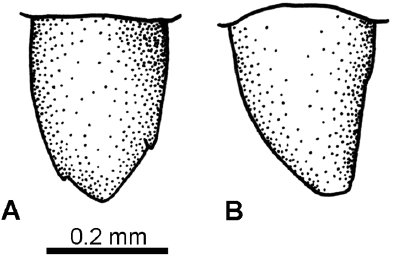
Fig. 3 – Brasiliguana prudentis gen. et sp. nov. Holotype MN 7230-V, detail of the crown of the ninth (A) and the twelfth (B) maxillary teeth in labial